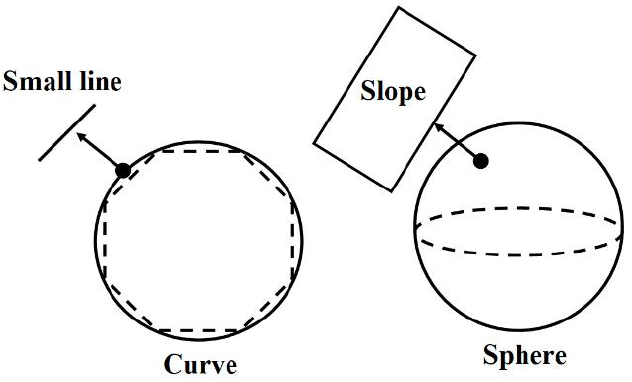
Figure 1. Image spherizing: ( a ) initial image; ( b ) spherized image. According to differential theory, an arbitrary curve can be divided into an infinite straight line segment, thereby we can deduce that an arbitrary sphere or hemisphere can be divided into infinite small wedges, as illustrated in Figure 2. In analogy to this conclusion, since optical microscope shows only a small region of the object surface, the deformation in this region can be considered as part of slope-shaped deformation. In other words, an arbitrary large-scale deformation can be approximatively considered as the sum of slope-shaped deformations.